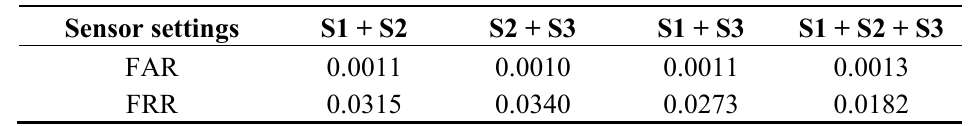
Table 5. Best performance (operation points closest to the performance target FRR ≤ 0.01 @ FAR = 0.001)—multi-sensor